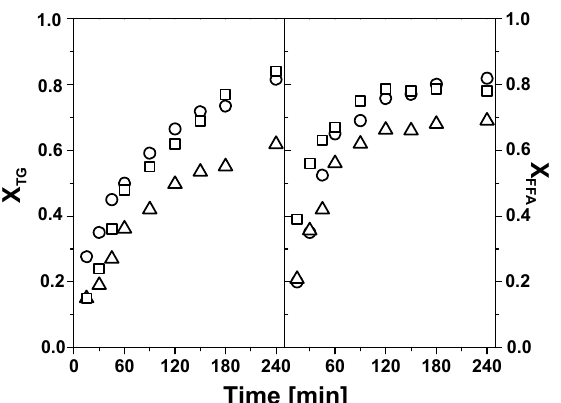
Figure 5. Conversion of the triglycerides (X TG ) and FFAs (X FFA ) with reaction time for the unsupported Mo (300) (squares), Mo (500) (circles), and Mo (700) (triangles) catalysts. Reaction conditions: 100 °C, 30 atm, methanol / feedstock molar ratio of 12:1, 2 wt.% catalyst referred to the feedstock mass. Feedstock: refined sunflower oil containing 5 wt.% free oleic acid.